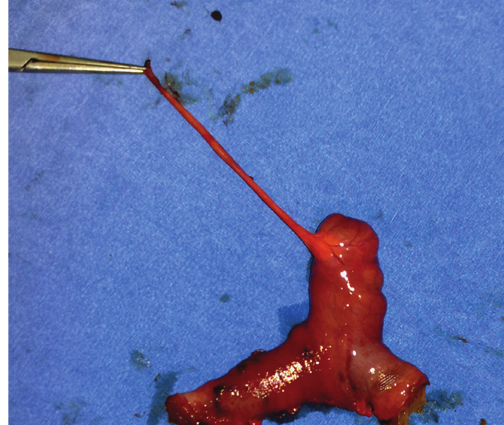
Figure 2: The view of resected Meckel’s diverticulum and mesodi- verticular